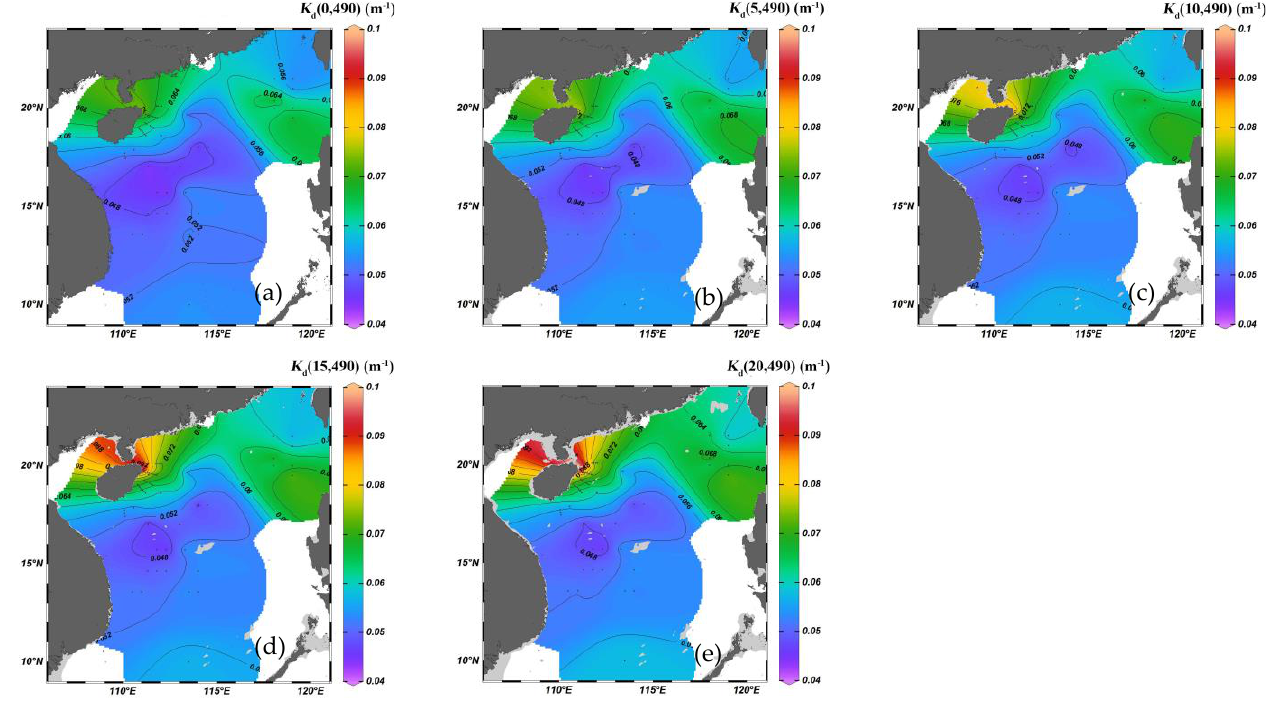
Figure 5. Spatial distribution of 𝐾 𝑑 (𝑧, 490) at ( a ) 0 m, ( b ) 5 m, ( c ) 10 m, ( d ) 15 m, and ( e ) 20 m un- derwater.